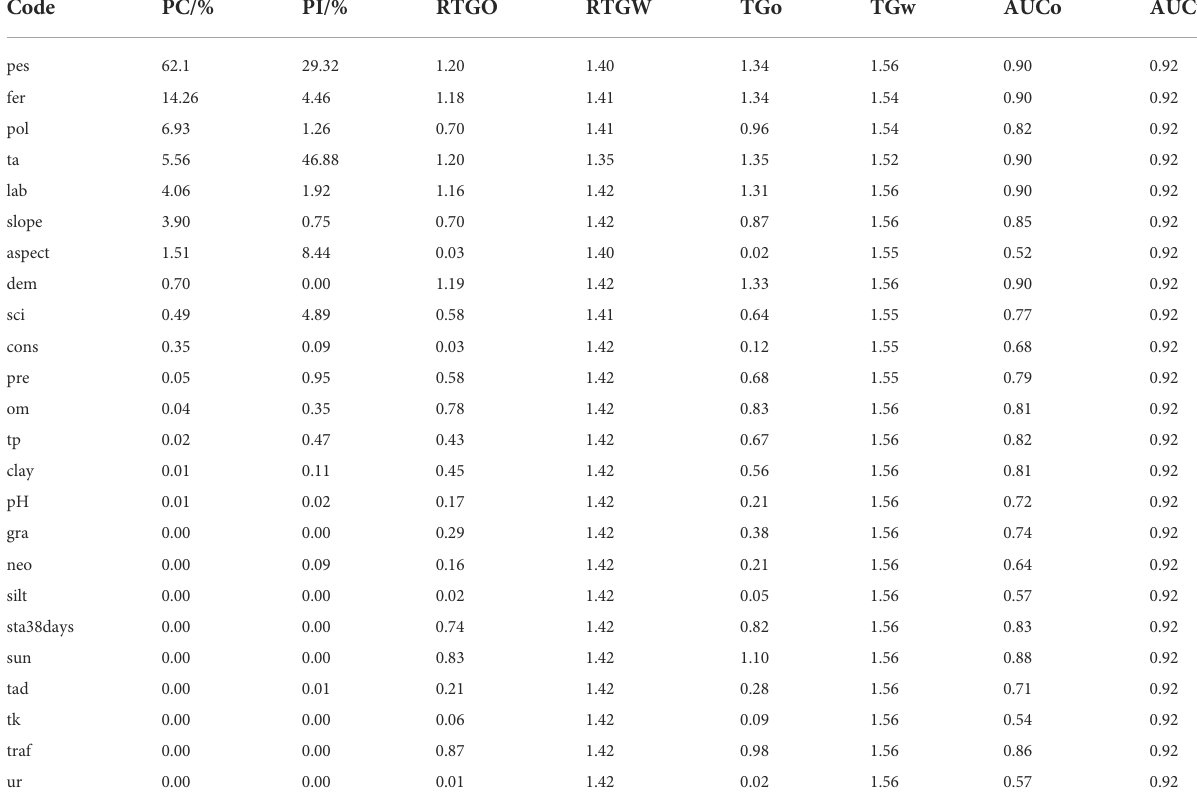
TABLE 5 Various parameters of the main environmental variables of